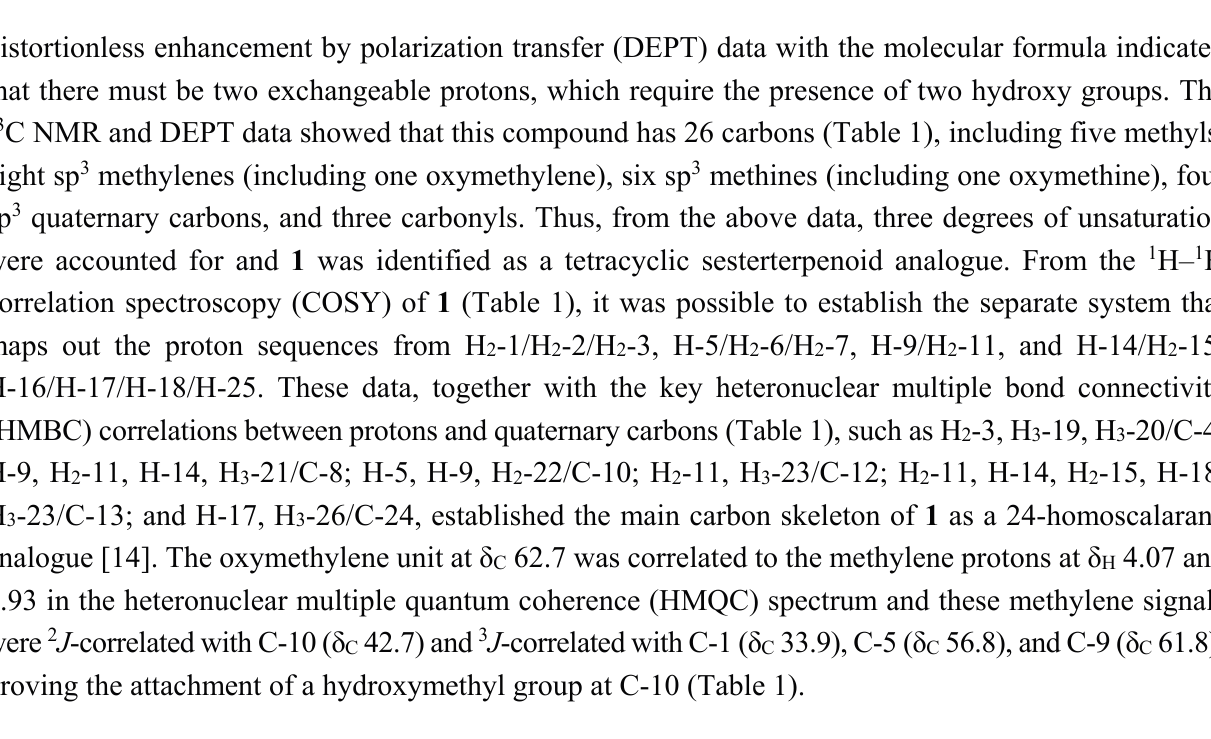
Table 1. 1 H (400 MHz, CDCl 3 ) and 13 C (100 MHz, CDCl 3 ) NMR data and 1 H– 1 H COSY and HMBC correlations for homoscalarane 1